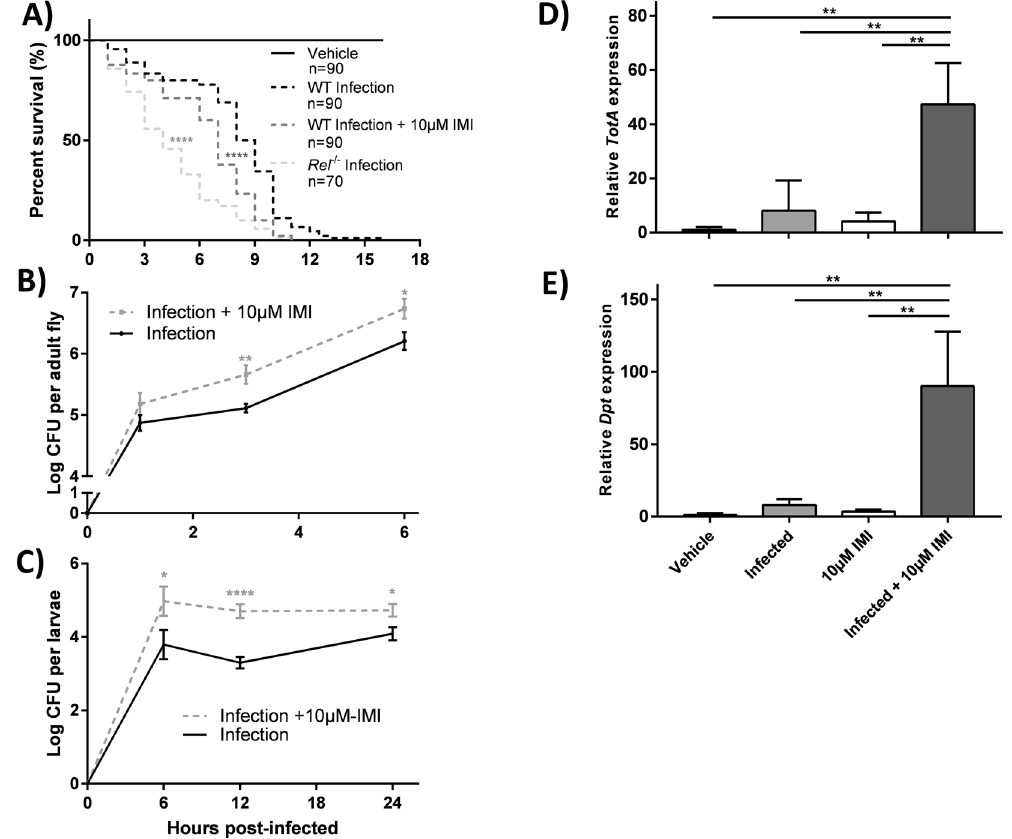
Figure 5. IMI-exposed D . melanogaster are more susceptible to septic infection with Serratia marcescens . ( A ) Survival curves for newly eclosed Imd pathway mutant ( Rel − / − ) and WT Canton-S flies subjected to septic infection ( S . marcescens NCIMB 11782) with or without concurrent exposure to IMI. All statistical symbols are representative of comparison made to infected WT Canton-S controls using the log-rank (Mantel-Cox) test. ( B ) Pathogen load of S . marcescens NCIMB 11782 during septic infection of WT flies was determined by plating surface-sterilized whole fly homogenates on LB agar medium. Colony forming units (CFU) per fly obtained at each time point represents the mean ± standard deviation (unpaired, two-tailed t-tests) of 9 biological replicates (n = 36 for each group). ( C ) Pathogen load of S . marcescens Db11 during oral infection of WT larvae was determined by plating surface-sterilized whole larvae homogenates on LB with 100 μ g/ml streptomycin medium. CFU per larvae obtained at each time point represents the mean ± standard deviation (unpaired, two-tailed t-tests) of 9 biological replicates for each time point (n = 36 total for each group). ( D , E ) TotA and Dpt gene expression of newly eclosed WT flies that were subjected to septic injury with or without S . marcescens NCIMB 11782 infection and with or without concurrent exposure to IMI. All samples were taken 6 h after experimental start time. Gene expression was quantified by RT-qPCR and is relative to vehicle flies that were subjected to septic injury with a sterile needle. Means ± standard deviations (two-way ANOVA) from 3 biological replicates (each consisting of 10 flies) with triplicate technical repeats are shown. * p < 0.05 ** p < 0.01, *** p < 0.001, **** p <